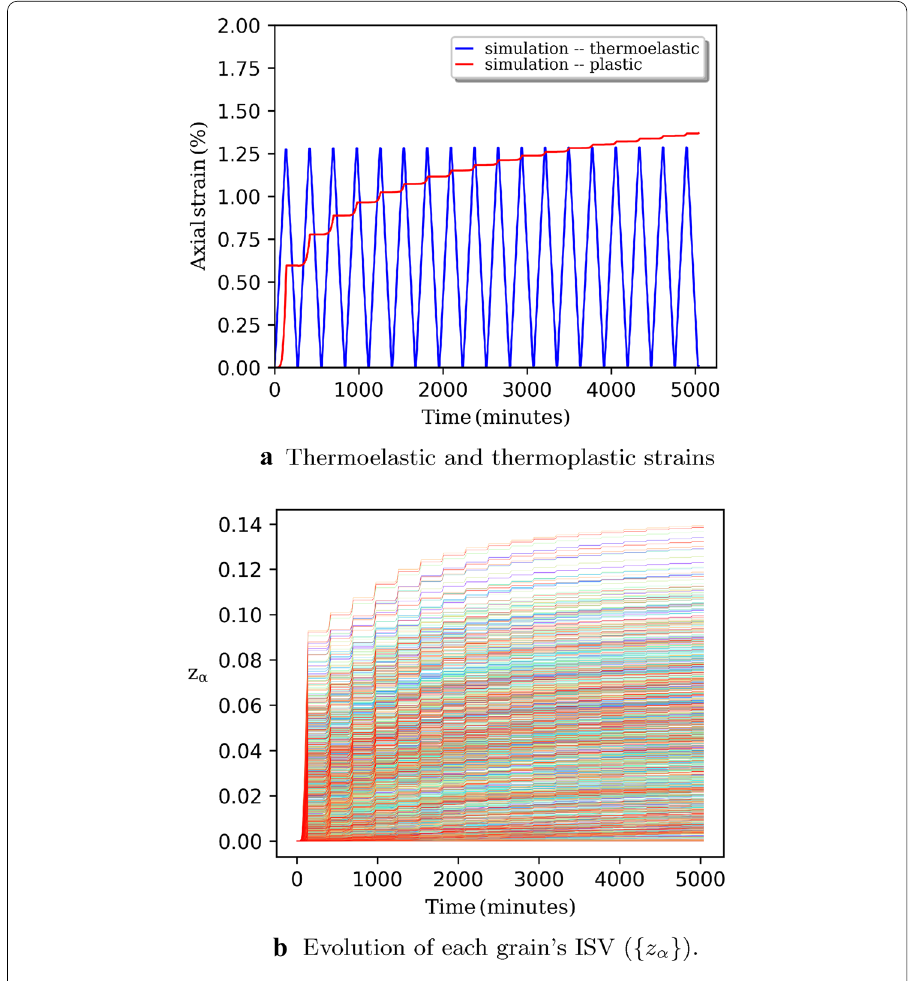
Fig. 7 TEPSCA simulation results: a break up of global strain into thermal and thermoplastic (“ratchet growth”) parts, and b evolution of strain-like ISV z for all 1000 grains of RVE showing some grains slip (thus harden) more than others